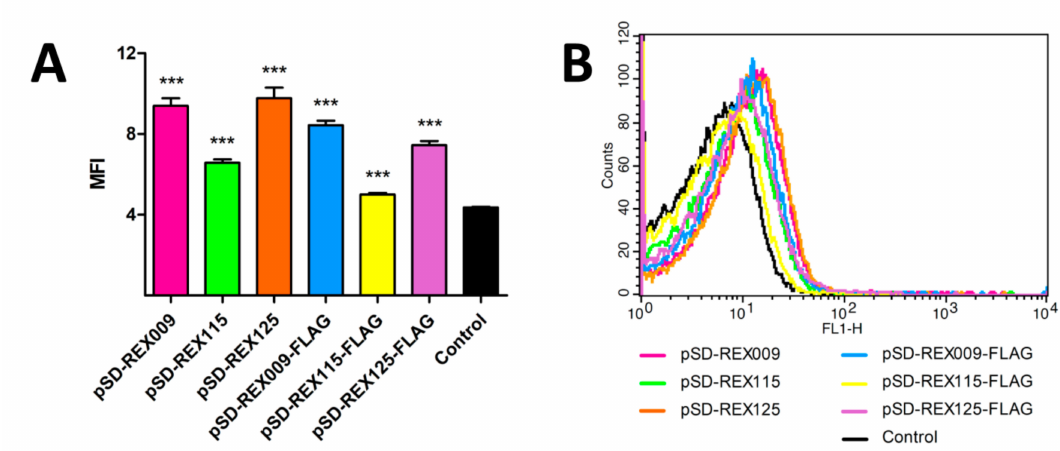
Figure 5. Flow cytometry of L. lactis cells displaying or secreting FLAG-tagged REX variants, detected with IL-23R-Fc fusion proteins. Control: L. lactis containing an empty plasmid of pNZ8148. ( A ) Mean fluorescence intensity (MFI) or ( B ) a shift in fluorescence intensity of representative measurements are depicted. Error bars denote standard deviations. Significant di ff erences *** p < 0.001; Student’s t -test) are marked with an